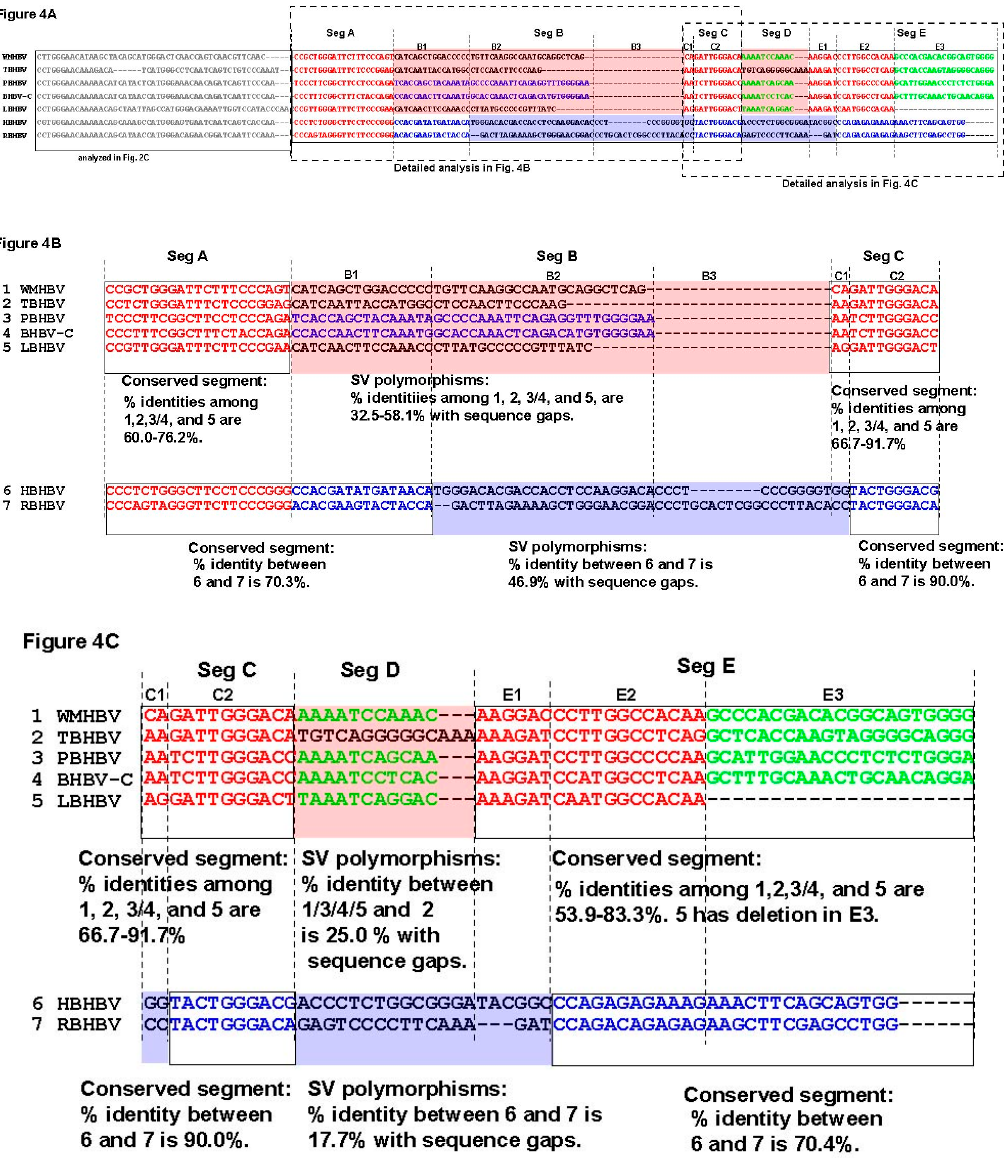
Figure 4. SV polymorphisms in part of pre-S1 region. WMHBV, TBHBV, PBHBV, BHBV-C, LBHBV, HBHBV, and RBHBV are shown as 1, 2, 3, 4, 5, 6, and 7, respectively, in the data analysis. ( A ), Alignment of part of the pre-S1 region. The multiple alignment data were analyzed using the data of sequence identities shown in Figure 3 and Figure S2A,B. The sequences were divided into five segments (Seg A to E) and additional sub-segments. PBHBV and BHBV-C showed high % identity in this region. The partial sequence segments with high identities obtained by pair-wise analysis (shown in Figure 3 and Figure S2A,B) are colored. Segments with relatively high % identities maintained among WMHBV and bat HBVs or WMHBV / TBHBV / PBHBV / BHBV-C / LBHBV are shown in red colored letters. Segments with relatively high % identities maintained between PBHBV and BHBV-C or HBHBV and RBHBV are shown in blue colored letters. Segment with relatively high % identities maintained among WMHBV and some of bat HBVs are shown in lime colored letters. SV polymorphisms observed in WMHBV, TBHBV, PBHBV, BHBV-C, and LBHBV are surrounded by red shaded rectangles. SV polymorphisms observed in HBHBV and RBHBV are surrounded by blue shaded rectangles. The consensus sequence of each species was used for analysis. Seg, segment. ( B ), The detailed analyses of SV polymorphisms observed in Seg B in WMHBV, TBHBV, PBHBV / BHBV-C, LBHBV, and those observed in Seg B2 + B3 +